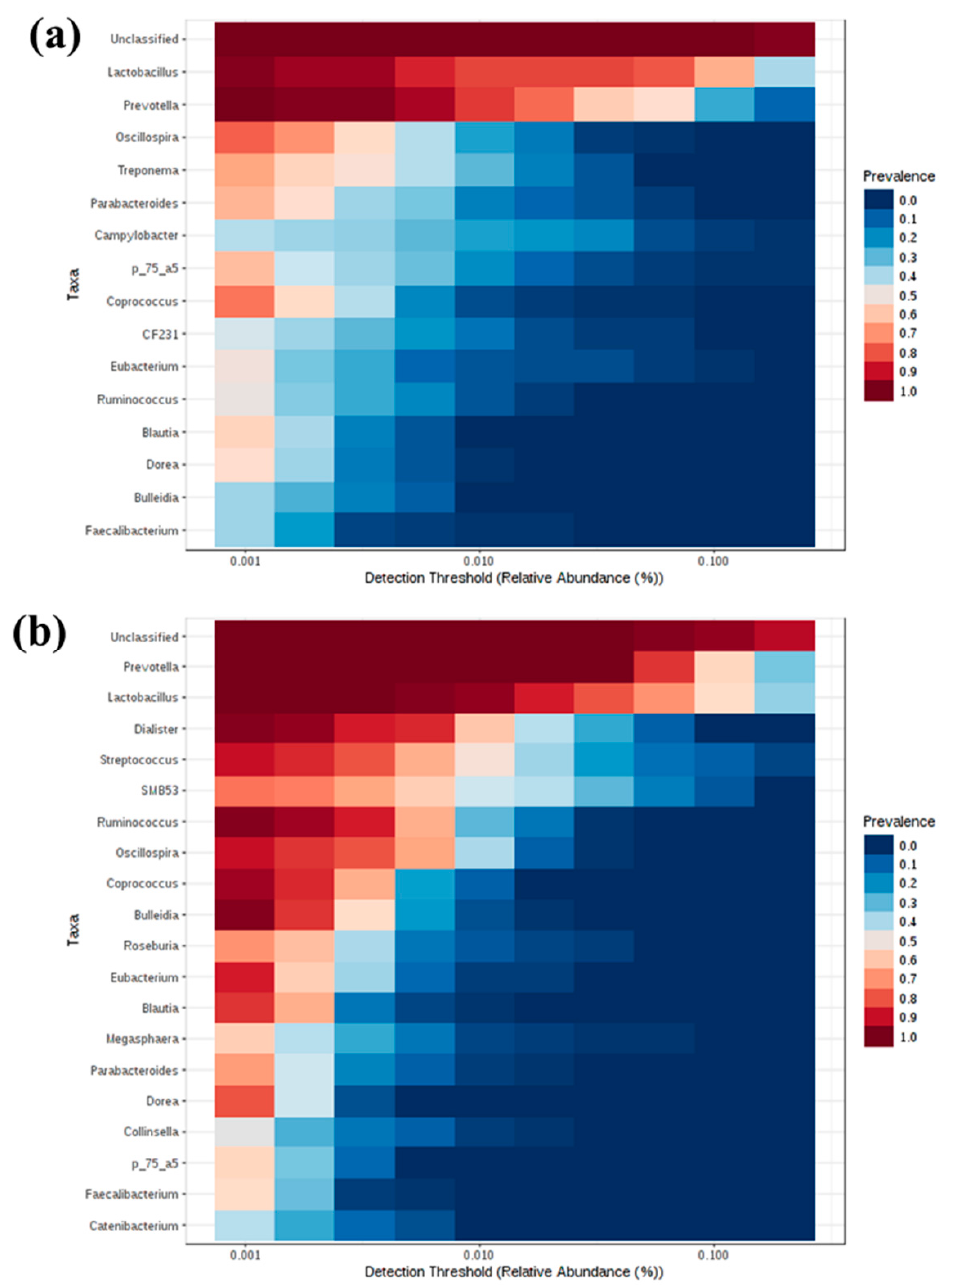
Figure 9. Core microbiota in pigs orally vaccinated with Lawsonia intracellularis vaccine. Heatmap depicting the core OTUs and their prevalence at different detection thresholds at ( a ) week 0 and ( b ) week (6).